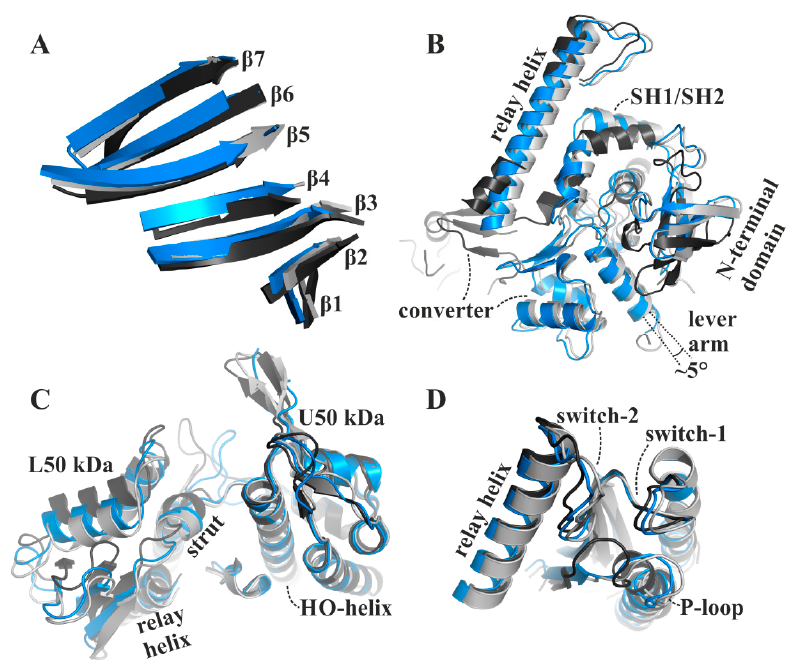
Figure 3. The blebbistatin-bound myosin-II · ADP structure (blue) feature characteristics of a myosin conformation between the pre-power stroke (black), and the rigor-like states (grey). ( A ) The transducer is partially twisted, particularly β -strands 1 to 3. ( B ) The relay helix and the converter approached the rigor-like position. The converter / lever arm must undergo a ~5 ◦ rotation to transition to the final rigor down position (grey). The N-terminal domain is markedly shifted towards its rigor position. ( C ) The large actin-binding cleft is found in a position between pre-power stroke (black) and rigor-like states (grey), thereby creating a new actin-binding interface. ( D ) The active site P-loop has moved ~9 Å from its pre-power stroke position in the blebbistatin-bound myosin-II · ADP conformation, but has not reached the rigor